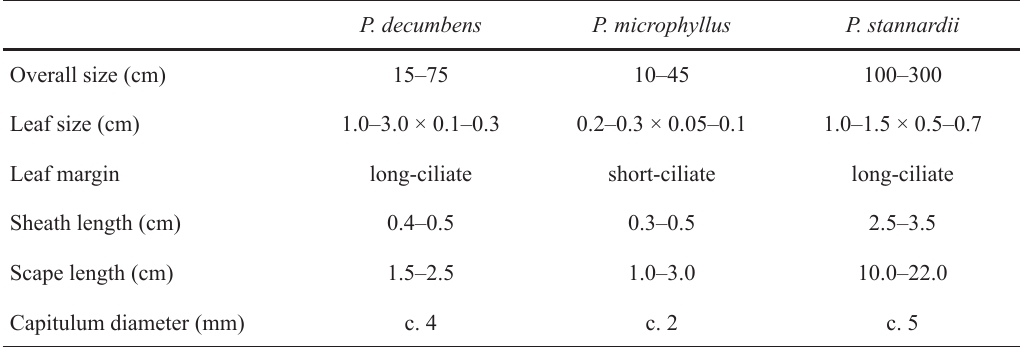
Table 3 – Main morphological differences of Paepalanthus decumbens , P. microphyllus , and P. stannardii . All measurements for P. microphyllus and P. stannardii are cited from Koernicke (1863), Ruhland (1903), and Giulietti & Parra (1995), combined with the herbarium